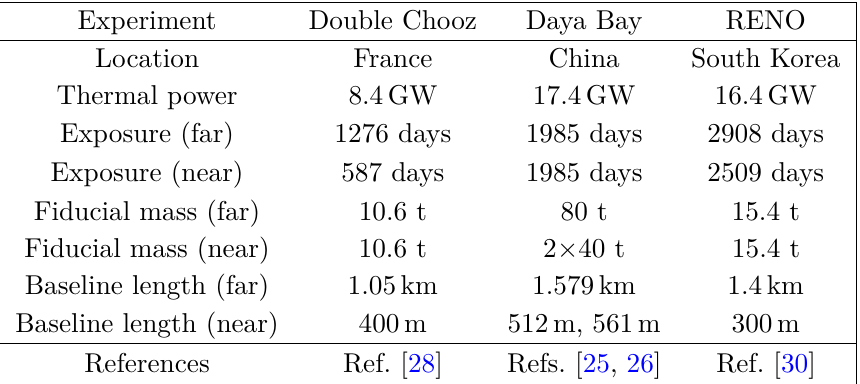
Table 1 . Reactor neutrino experiments considered in this study. Each of the reactor experiments have two or more detectors based in different locations. The baseline lengths correspond to the average distance between the reactors and detector compounds.